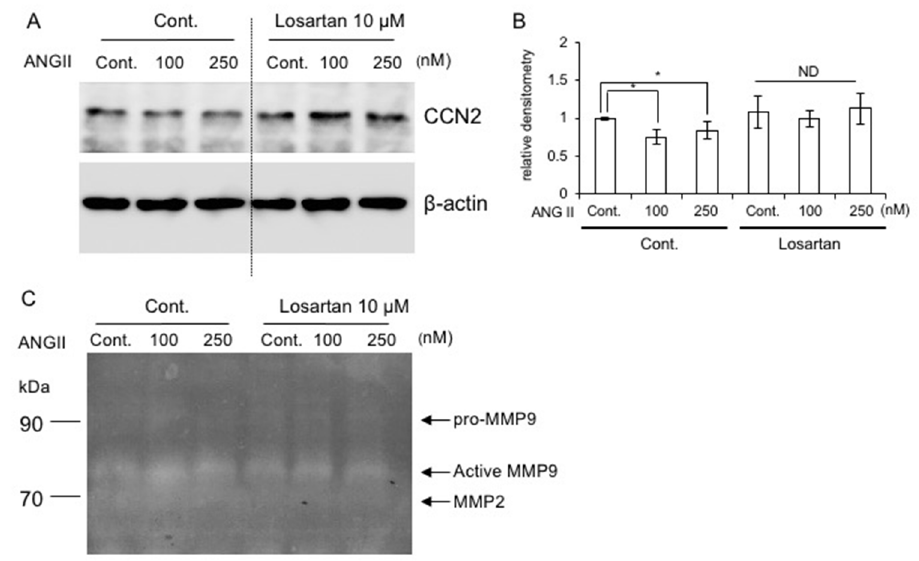
Figure 5. Effect of losartan on the production of CCN2 in RCS cells. ( A ) RCS cells were pre-treated with 10 µ M losartan potassium for 30 min and were stimulated with ANG II at 100 and 250 nM for 24 h. ( B ) The amount of CCN2 was determined densitometrically, and these amounts were normalized to the amount of β -actin. Relative densitometry (control without losartan = 1.0) is presented and was analyzed by Bonferroni’s test. The asterisk indicates a significant difference from the control at * p < 0.05. ND represents “no difference”. ( C ) Effect of losartan on secreted gelatinases in the culture medium from RCS cells treated with 100 and 250 nM ANG II for 24 h. Gelatin-substrate zymogram was performed.